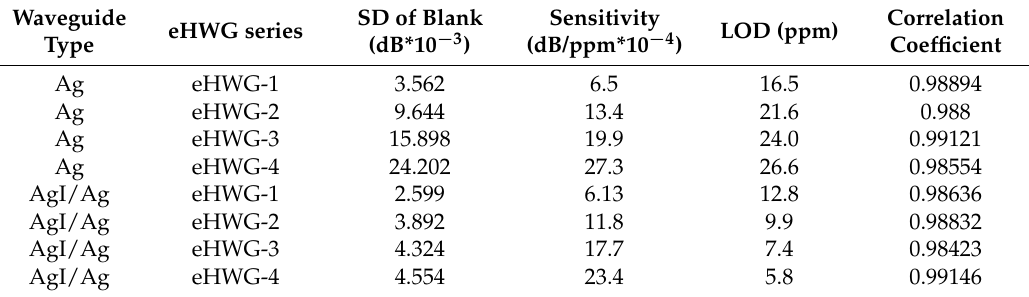
Table 2. Performances for eHWG with an Ag or AgI/Ag waveguide (ID = 1.4 mm).